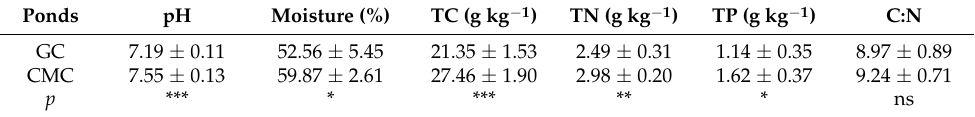
Table 1. Characterizations of sediments from aquaculture ponds examined for this study.